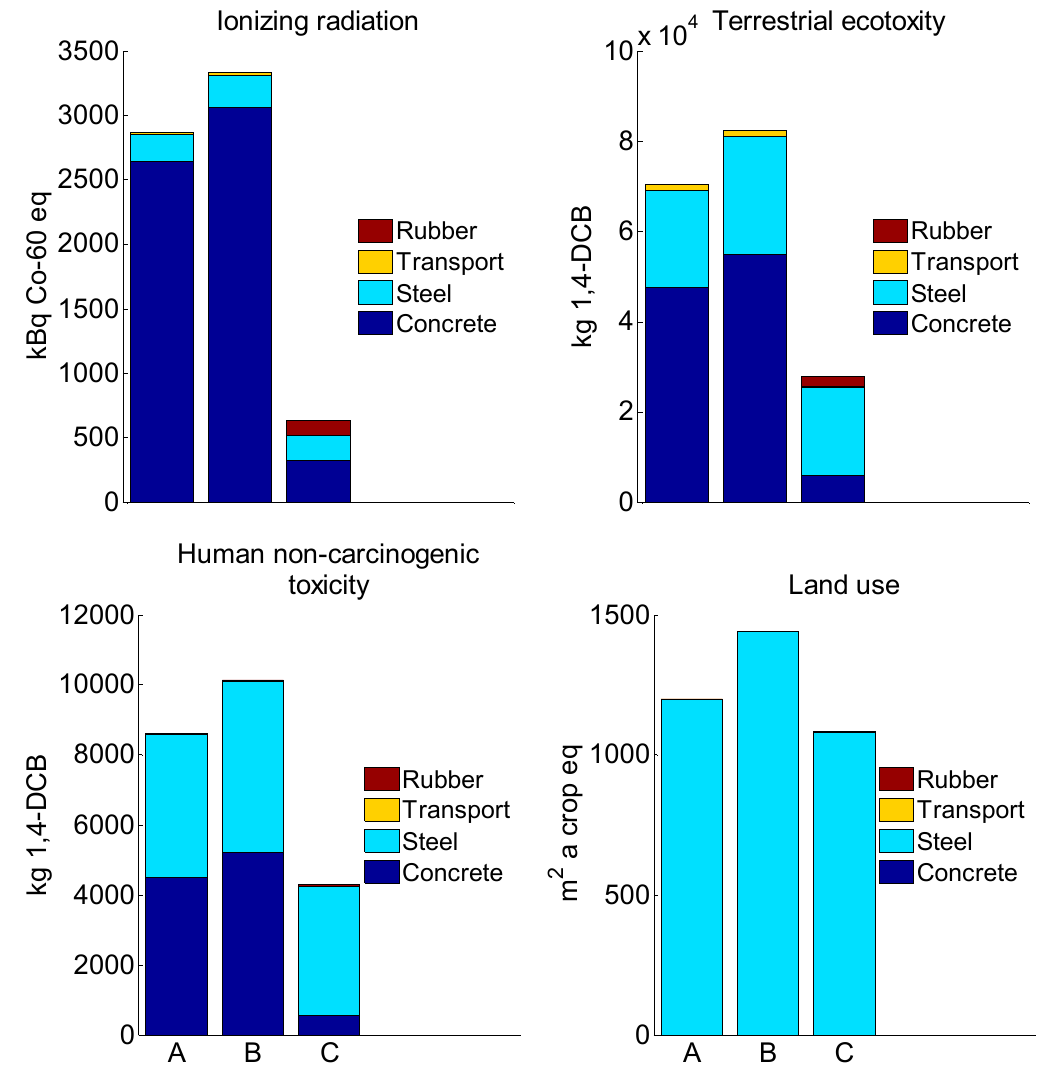
Figure 9. (A) Case 1, (B) Case 2, and (C) Case 3 evaluated with the ReCiPe 2016 midpoint method.